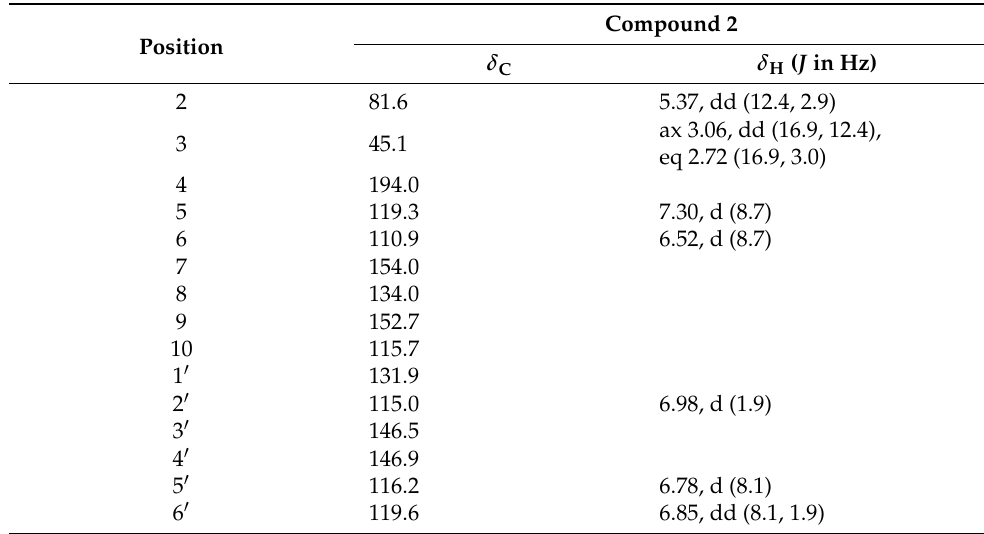
Table 2. 1 H and 13 C NMR data ( δ in ppm, J in Hz) of isookanin in methanol-d 4 (500